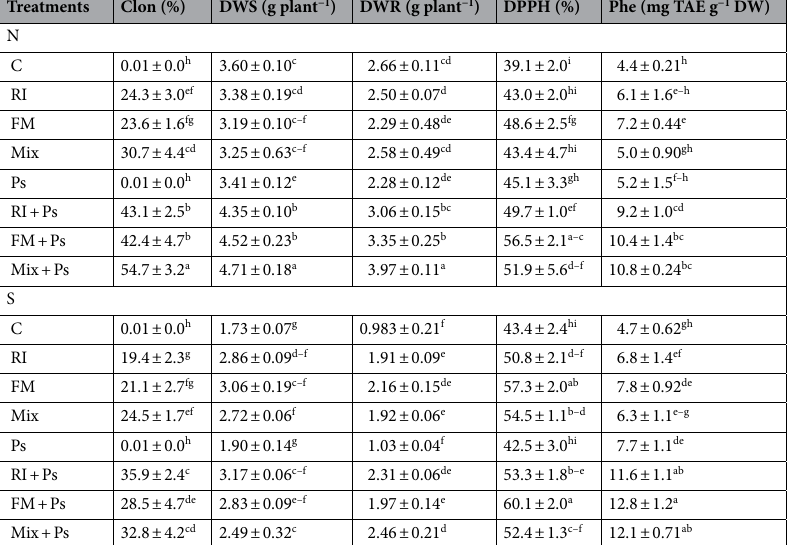
Table 3. Interaction effects of irrigation regime × AMF × PGPR on root colonization (Clon), shoot dry weight (DWS), root dry weight (DWR), DPPH activity, and total phenolic (Phe) of Arizona cypress seedling. Means (± SD) followed by similar letters within each column do not express signifiant diffrences according to LSD at P < 0.05. N well watered (100% field capacity); S water stress (50% field capacity), RI Rhizophagus irregularis , FM Funneliformis mosseae , Mix: R. irregularis – F. mosseae mixture, C non-inoculated plants, Ps Pseudomonas fluorescens , TAE tannic acid equivalent.